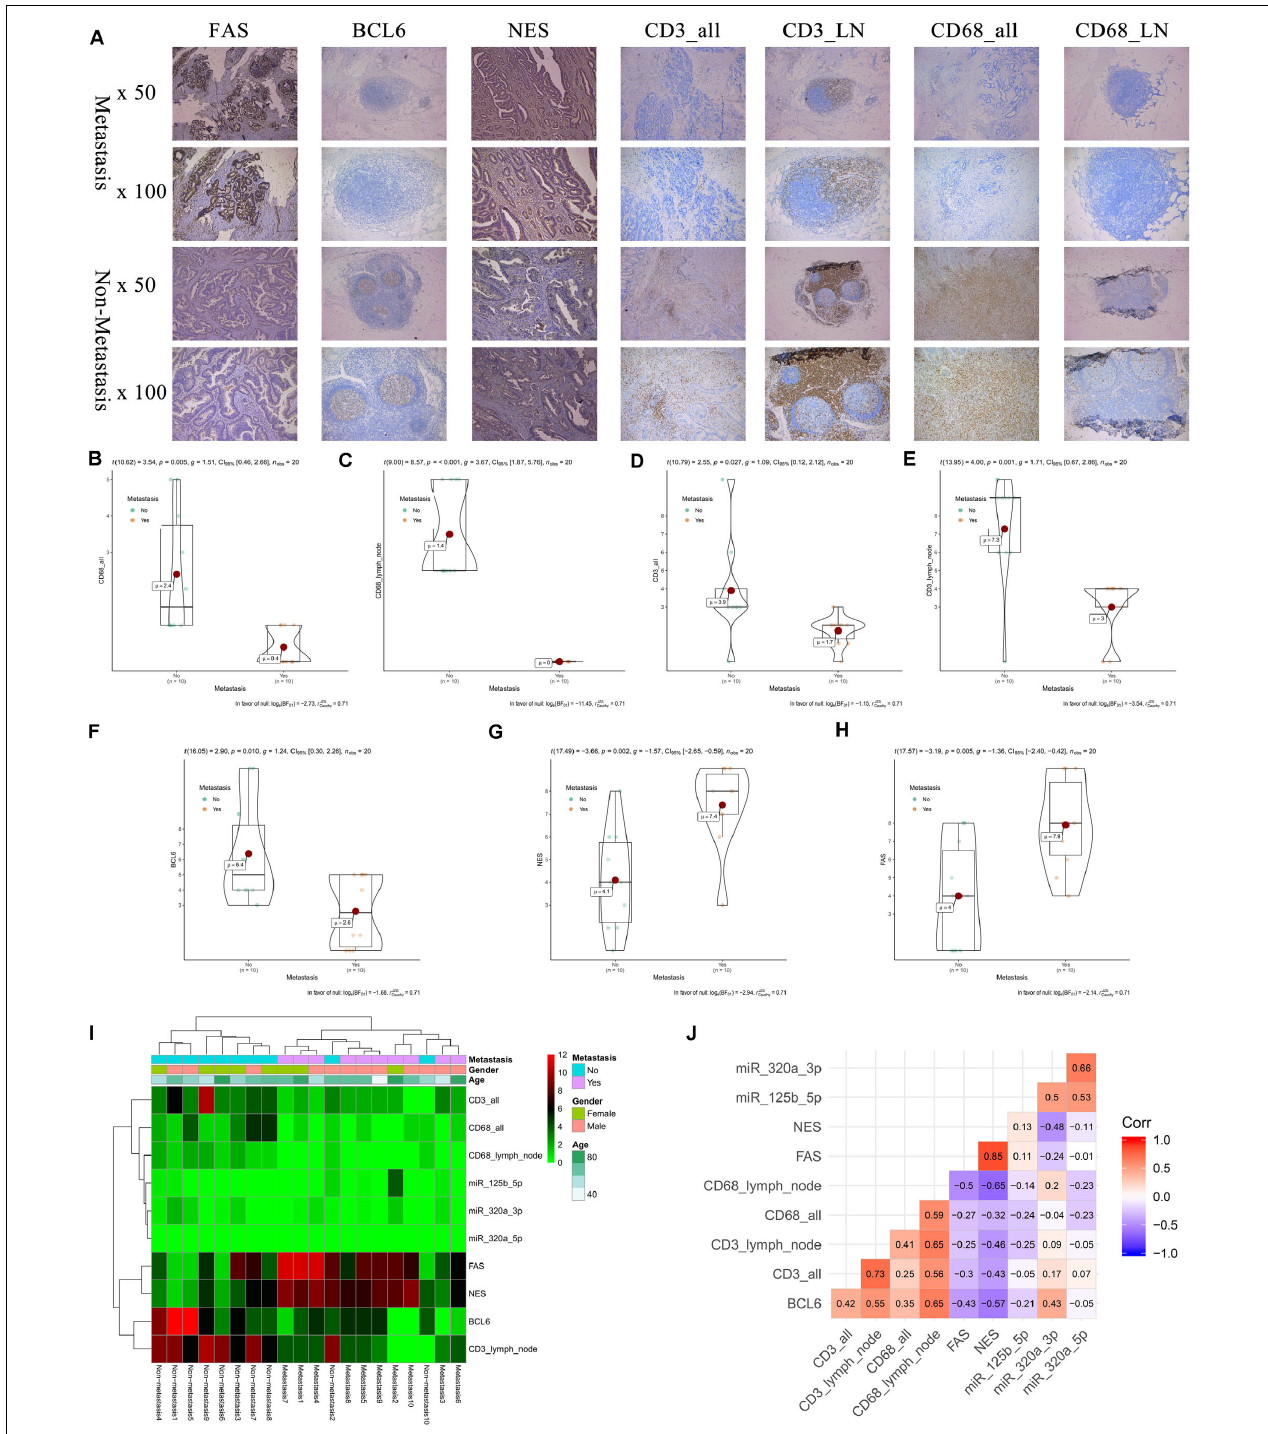
FIGURE 9 | The results of preliminary clinical specimen validation. The results of IHC (20 primary COAD samples including 10 with metastasis and 10 without metastasis) suggested that proteins of FAS, NES, CD3, CD68, and BCL6 were significantly different in COADs diagnosed with metastasis and without metastasis (A) . The results of non-parametric tests also confirmed that these differences were statistically significant (CD68 in all tissue, P = 0.005; CD68 in lymph nodes, P < 0.001; CD3 in all tissue, P = 0.027; CD3 in lymph nodes, P = 0.001; BCL6, P = 0.010; NES, P = 0.002; FAS, P = 0.005) (B–H) . The expression levels of FAS, NES, CD3, CD68, BCL6 and key miRNAs (miR-320a-3p, miR-320a-5p, and miR-125b-5p) in the ceRNA network were illustrated in the heatmap (I) . Additionally, despite the limitation to the sample size, Additionally, despite the limitation to the sample size, CD68 (Marker of Macrophages M0) and FAS ( R = –0.500), CD68 and NES ( R = –0.650) shown co-expression trends (J)